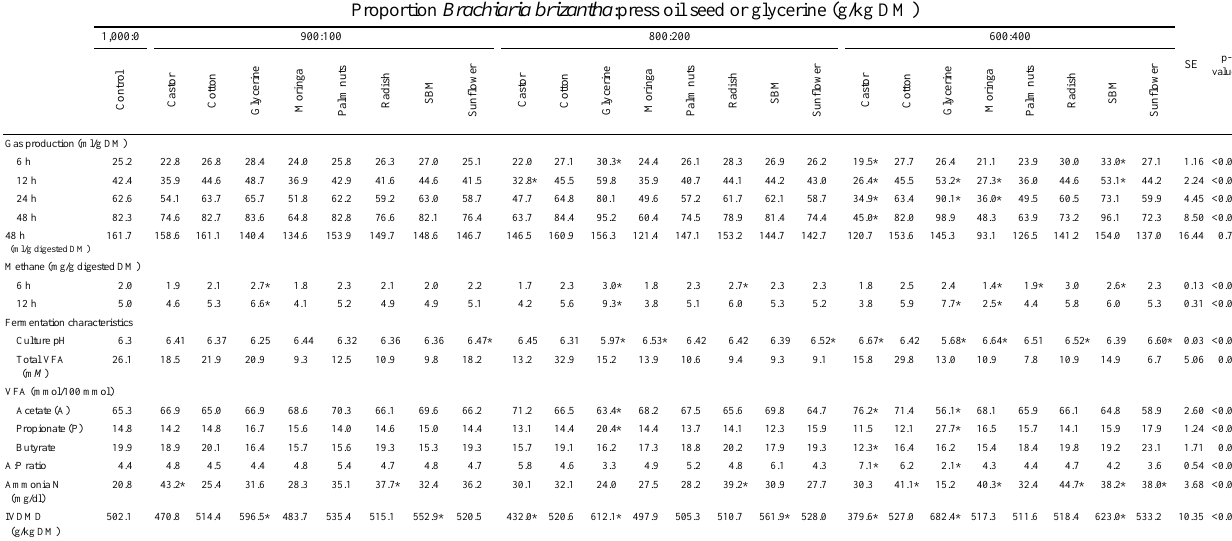
Table 4. Effects of increasing levels of oilseed press cakes, glycerine and soybean meal (SBM) as replacement of Brachiaria brizantha (control) on 48 h fermentation characteristics and in vitro methane production Proportion Brachiaria brizantha :press oil seed or glycerine (g/kg